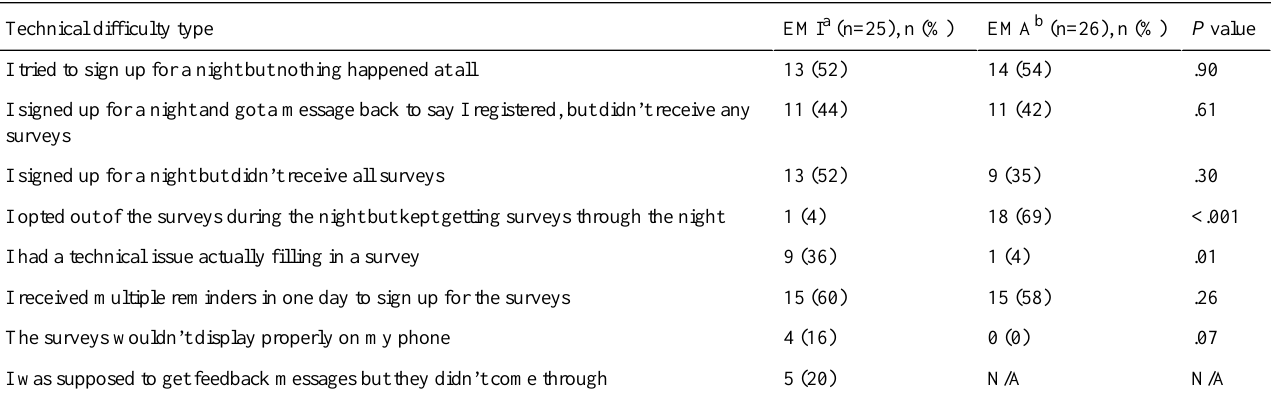
Table 5. Participants’experience of technical difficulty by the study group trial arm: counts (%) and P values from chi-square inferential